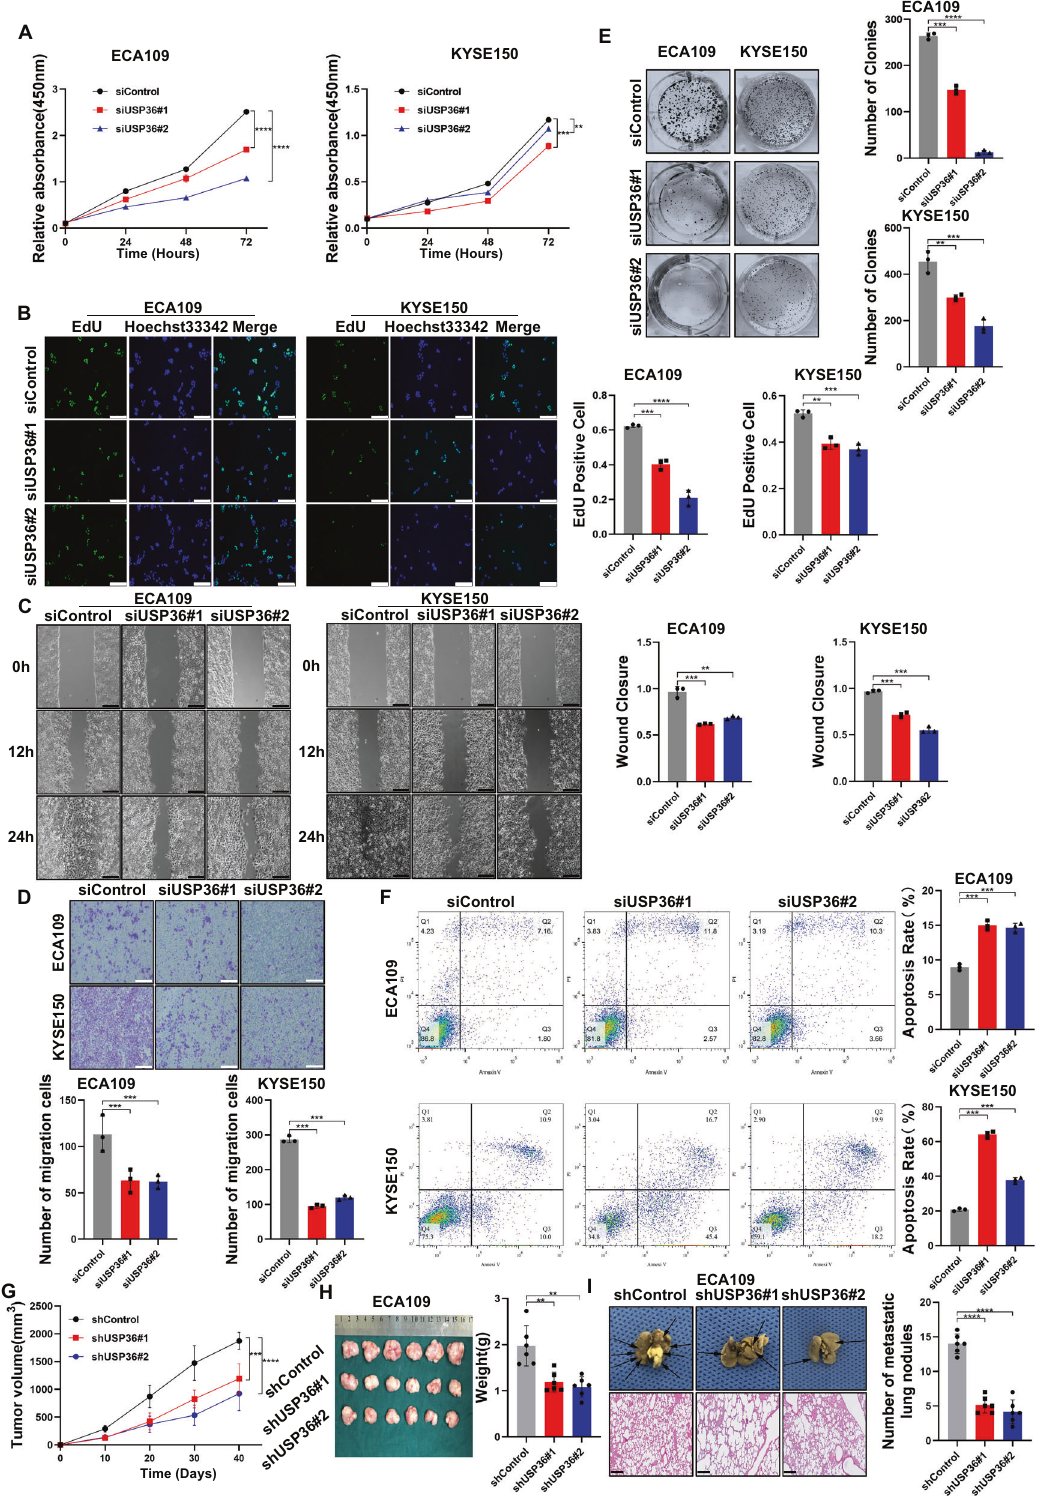
(cleaved) protein levels (Fig. S2I). The 3D culture assay indicated that USP36 was required for sphere formation in ECA109, KYSE150, and EC9706 cells (Fig. S2J). We further evaluated the effect of USP36 in vivo. The xenograft model demonstrated that USP36 depletion signi fi cantly reduced ESCC tumor growth in